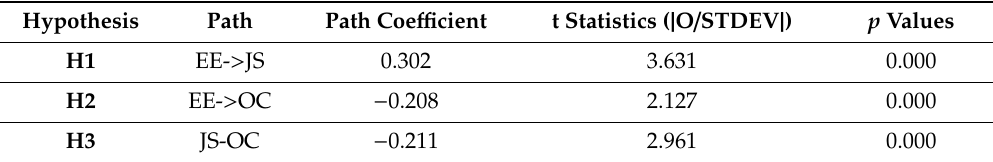
Table 3. Hypothesis results by bootstrapping (direct relationships).